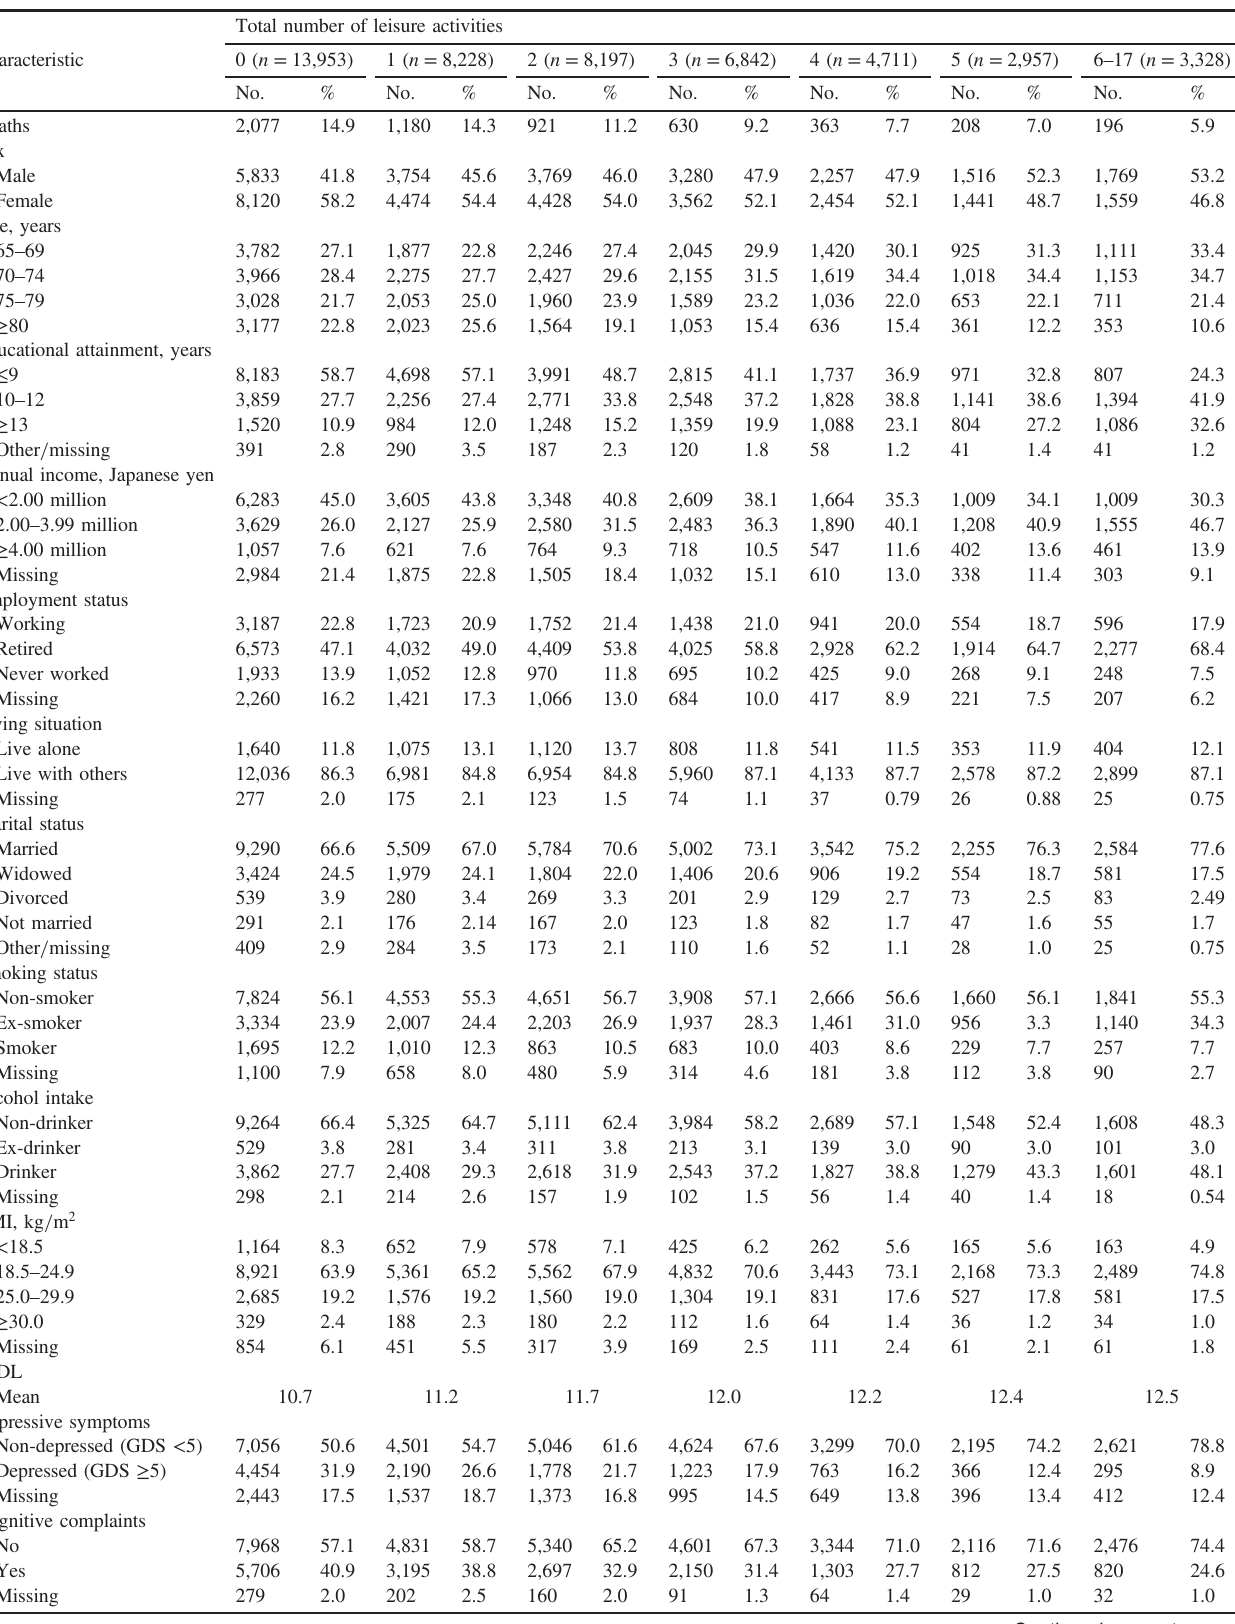
Table 1. Baseline characteristics of older Japanese participants ( n = 48,216) who were 65 years of age or older, Japan, 2010 – 2016